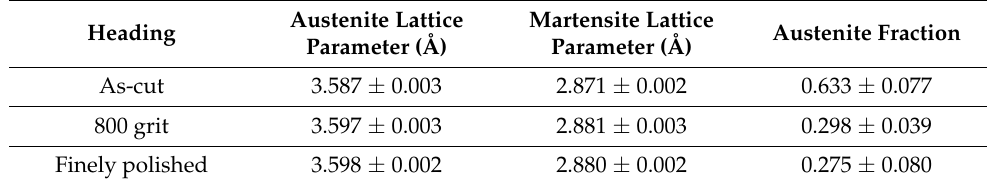
Figure 4. Location-specific ( a ): BCC (martensite) lattice parameter, ( b ): FCC (austenite) lattice parameter, and ( c ): austenite fraction of the 17-4 sample with finely polished surface. The position indices are the same as specified in Figure 2. Table 3. Statistical austenite lattice parameter, martensite lattice parameter, and austenite fraction from in-house XRD measurements. The uncertainties are reported in one standard